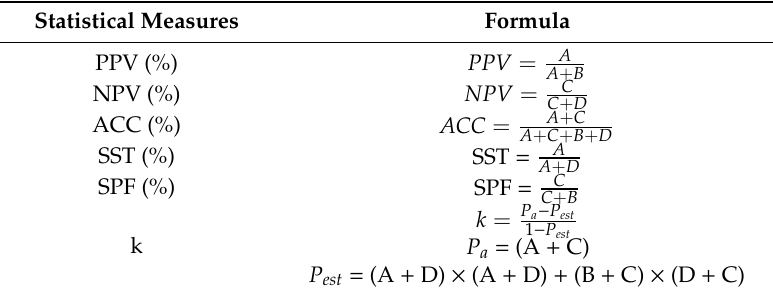
Table 3. List of statistical measures employed in this research [101–105]. Statistical